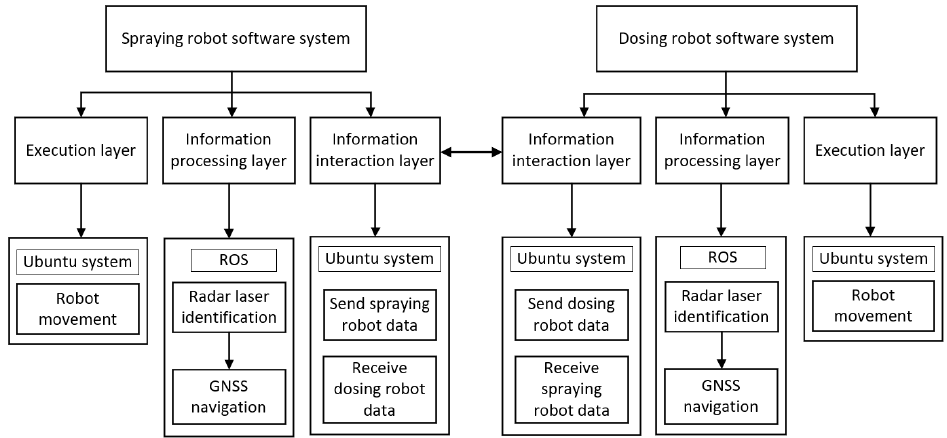
Figure 2. Software system structure of the spraying–dosing robot.